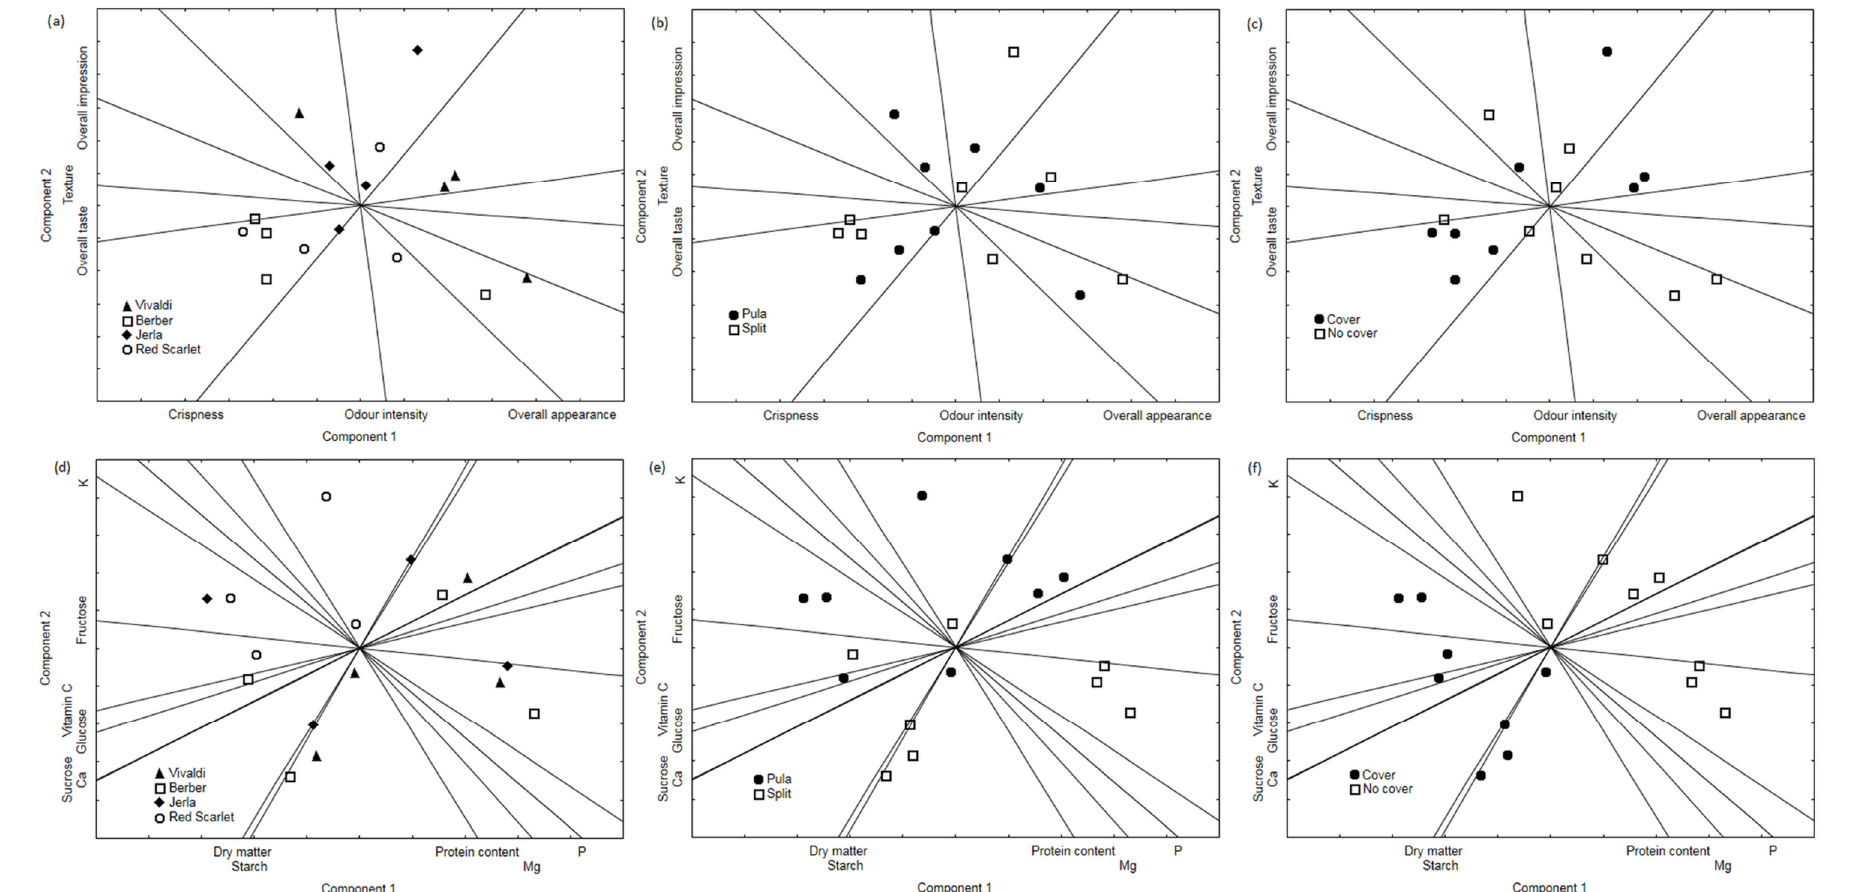
Figure 3. PLS models of the effect of ( a ) cultivar, ( b ) location, ( c ) plant cover on “early” potato physicochemical parameters and the effect of ( d ) cultivar, ( e ) location, ( f ) plant cover on oil-fried “early” potato sensory characteristics in the second harvest year.